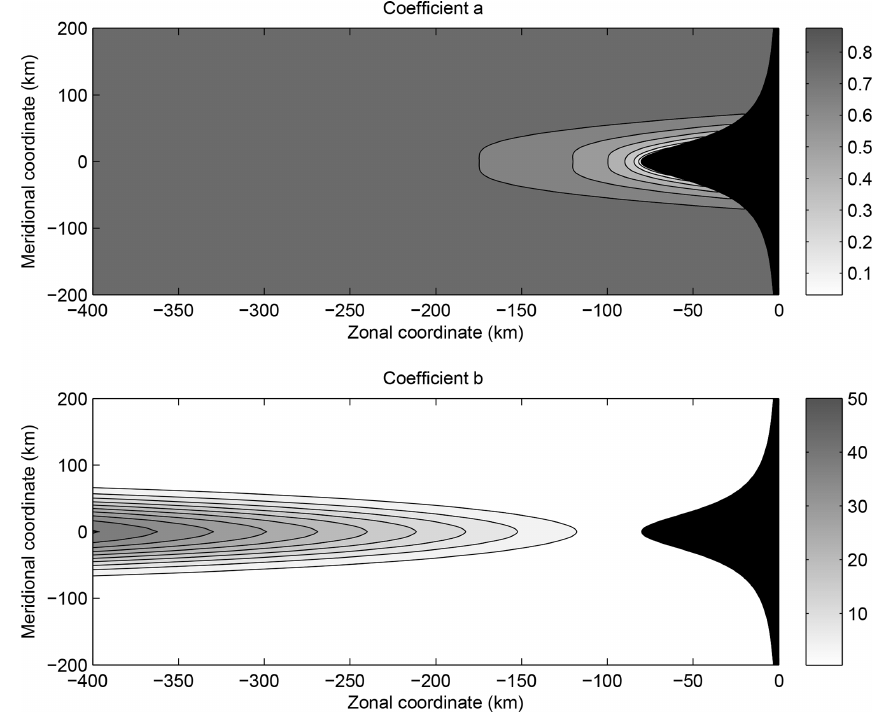
Figure 10. The coefficients a and b are given for the coordinate system of Fig. 9 (they have no dimension).